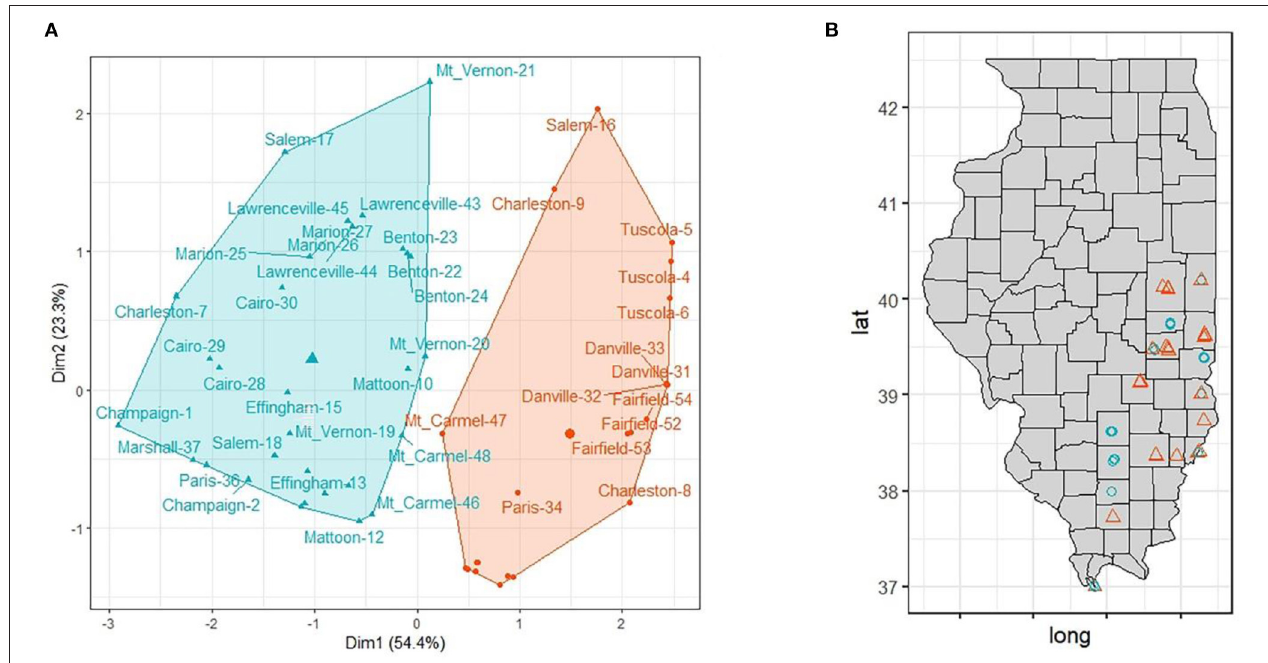
FIGURE 5 | Redundancy analyses (RDA) ordination diagram for culicid species (in blue) and landscape variables (arrows in red) data collected in 54 sampling sites in Illinois. The full model explained 14% of the total variance, the first two constrained axis explained 7% (RDA1) and 6% (RDA2). Ae_canad, Aedes canadensis ; Ae_albo, Ae. albopictus ; Cx_pip_com, Culex pipiens complex; Ae_vex, Ae. vexans ; Ps_ferox, Psorophora ferox ; Ps_columb, Ps. columbie ; Ps_cyane, Ps. cyanescens ; An_cruci, Anopheles crucians ; An_quad, An. quadrimaculatus ; An_puncti, An. punctipennis .